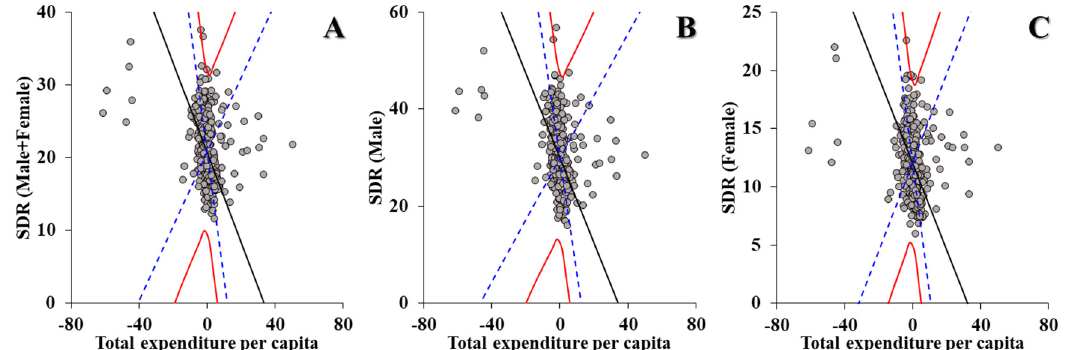
Figure 2. Correlation between total amount of the financial expenditure per capita of prefectures and municipalities, and suicide mortality of males and females together ( A ), males ( B ), and females ( C ) from 2009 to 2018 using fixed- or random-effect analysis of hierarchal linear regression with robust standard error. Ordinates and abscissas, standardised death rates for suicide mortality based on Japanese age-dependent population composition in 2009 (SDR) of males and females together, males, and females per 100,000 population, and centralised total amount of financial expenditure per capita of prefectures and municipalities (JPY 10,000), respectively. Black, blue, and red lines, slope of fixed effects, standard deviation of fixed effects, and fixed effects with random effects, respectively.